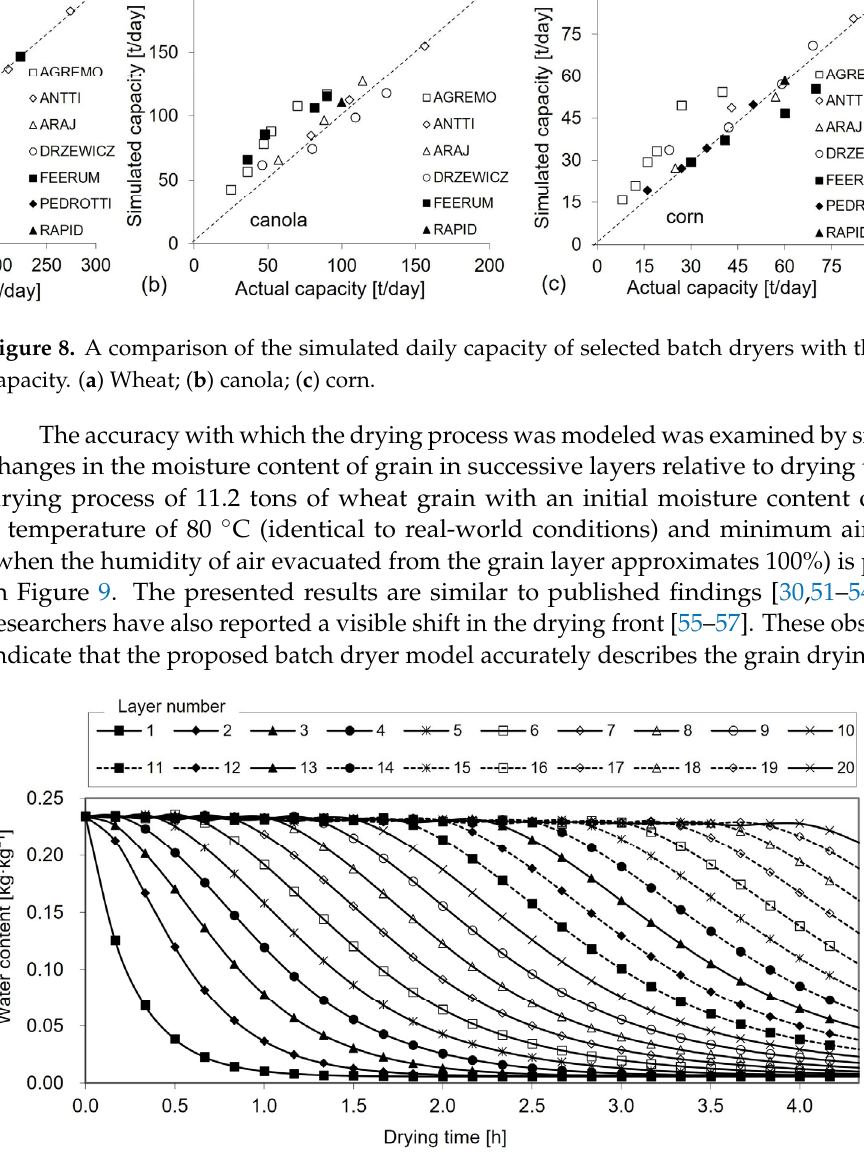
Figure 9. Simulated changes in the moisture content of successive layers of dried wheat grain.